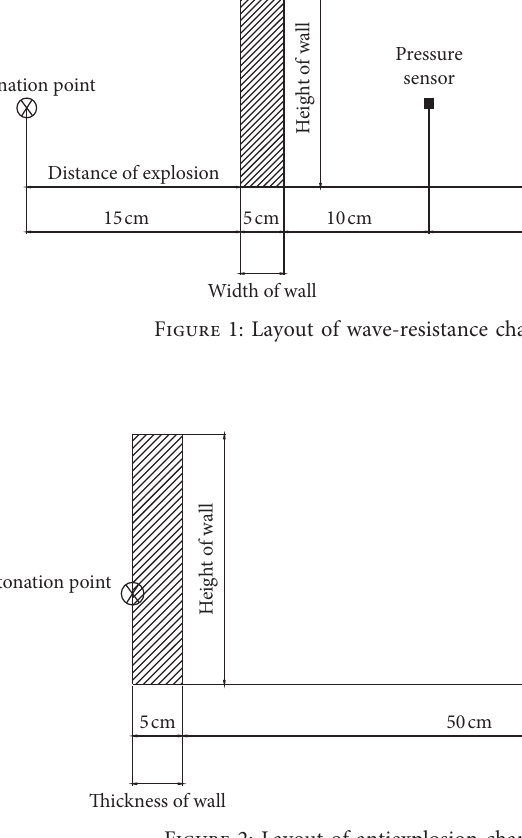
Figure 2: Layout of antiexplosion characteristics test.